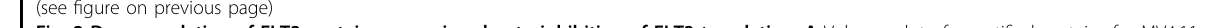
Fig. 2 Downregulation of FLT3 protein expression due to inhibition of FLT3 translation. A Volcano plot of quanti fi ed proteins for MV4:11 treated with 50 nM OTS167 for 8 h, graphed by log2 change (x-axis) and -log P value (y-axis). Threshold for determining signi fi cant expression changes is indicated by a dashed line ( P < 0.05). B Enrichment analysis of downregulated proteins in MV4:11 treated with 50 nM OTS167 for 8 h. Displayed is an aggregation of Gene Ontology (Cellular Component (GOCC), Biological Process (GOBP), Molecular Function (GOMF)), Corum, and Kyoto Encyclopedia of Genes and Genomes (KEGG) enrichment scores. Enrichment scores were calculated using -log P value. C Fold change in FLT3 mRNA assayed by qPCR in MV4:11 or MOLM-14 after treatment with 50 nM OTS167, 50 nM gilteritinib, 50 nM midostaurin, or 50 nM crenolanib for 24 h. (3 biological replicates; 3 technical replicates each). D Western Blot analysis of FLT3 expression in MV4:11 over time after treatment with 100 ug/ mL cycloheximide or 100 ug/mL cycloheximide plus 50 nM OTS167. (2 biological replicates)(single blot). E Band quantitation of Fig. 2D. Band values for each time point are normalized fi rst to tubulin in each lane, then to 0 h time point. The difference between the linear regression curves (shown with dashed 95% con fi dence interval) were not statistically signi fi cant. F Western blot analysis of nascent FLT3 protein expression in MV4:11 at 4 and 24 h. MV4:11 were treated with 100 ug/mL cycloheximide and indicated drug (50 nM OTS167, 50 nM gilteritinib or 100 nM midostaurin) for 3 h, washed, then treated with same indicated drug (50 nM OTS167, 50 nM gilteritinib, or 100 nM midostaurin) for 4 or 24 h. (3 biological replicates)(single blot) Graph of four biological replicates (MV4:11 or MOLM-14) shows density of p130 FLT3 band as a percent total of control. G Fold change in FLT3 mRNA assayed by qPCR in MV4:11 at 24 h. (1 biological replicate; 3 technical replicates). H Western blot analysis of nascent c-Myc and MCL-1 protein expression in MV4:11 at 4 and 24 h as described in Fig. 2F. (1 biological replicate)(single blots as indicated). I Representative OD254 spectra of cell lysates fractionated to separate monosomes and polysomes in control MV4:11 cells or MV4:11 cells treated with 50 nM OTS167 for 4 h. (2 control biological replicates, 3 OTS167 biological replicates). J Ratio of quantitative measurements (area under the curve) of pooled monosomal and pooled polysomal peaks using ImageJ. (2 control biological replicates, 3 OTS167 biological replicates). K Fold change of FLT3 mRNA in pooled polysomal fractions assayed by qPCR. (3 biological replicates each) (**** P < 0.0001, ** P < 0.01, ns-not signi fi